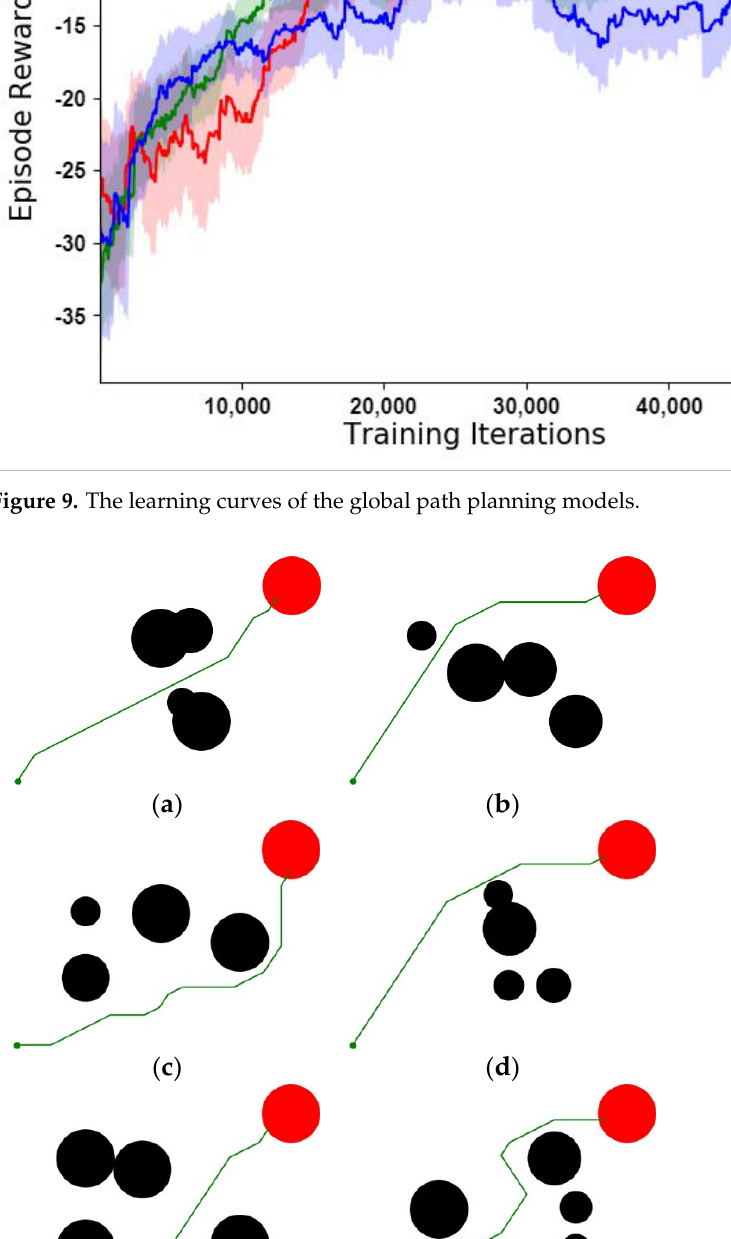
Table 6. The global path planning performance of different planners. Policy ( b ) Figure 11. The global path planning results comparison. ( a ) D3RQN, ( b ) RRT.